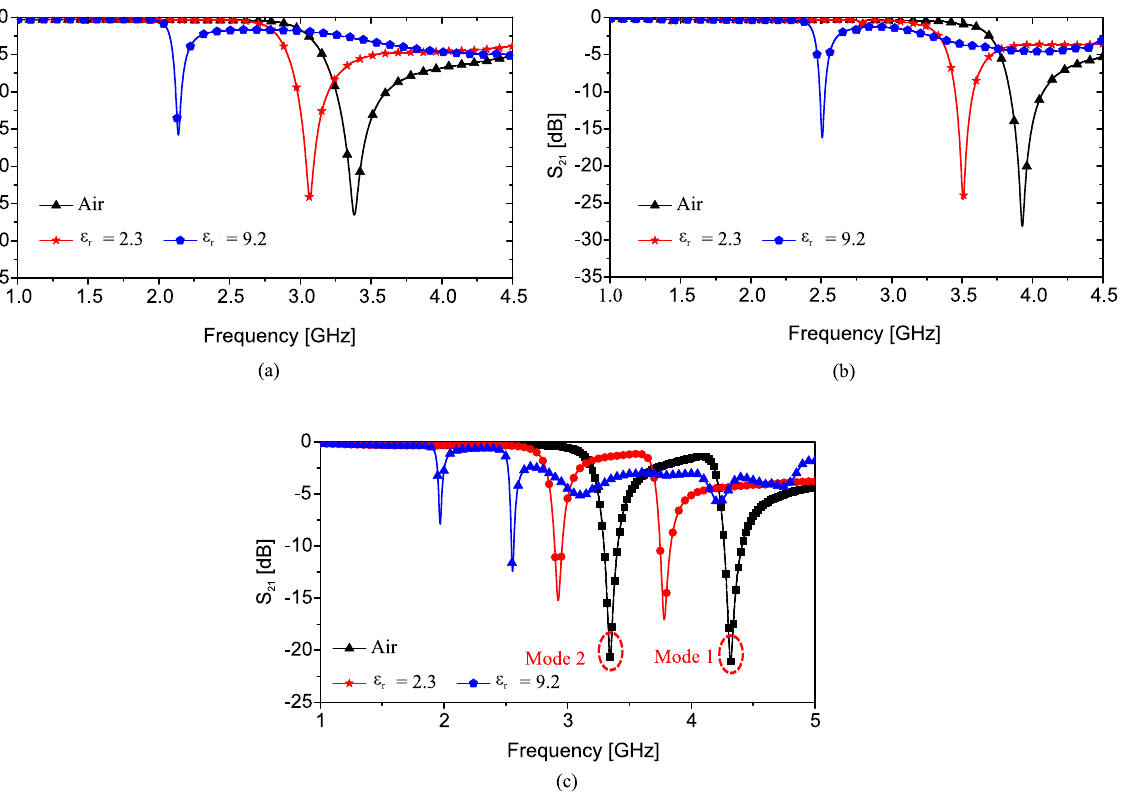
Figure 8. Experimentally measured transmission coefficient ( | S 21 | ) of the fabricated 1CSRR ( a ), 2CSRR ( b ) and 4CSRR ( c ) sensors. Reprinted with permission from Ref. [33].